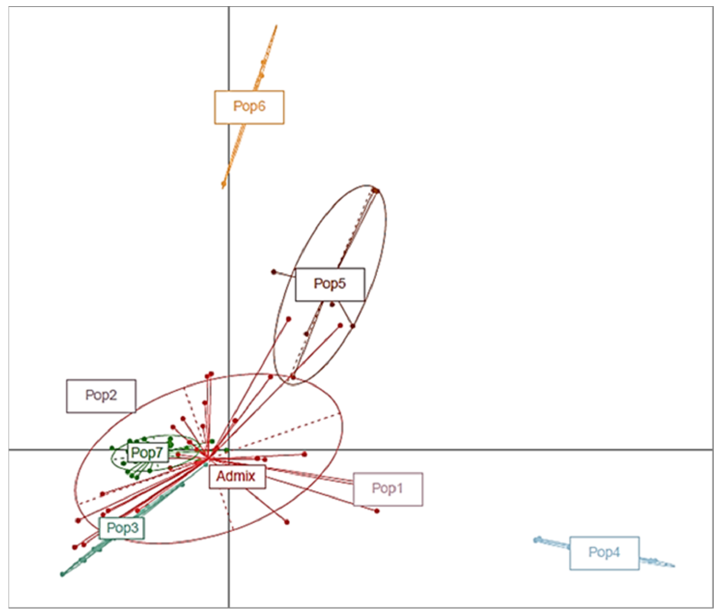
Figure 3. Principal coordinate analysis (PCoA). The analysis depicts the overall genetic diversity of the germplasm for 96 olive accessions using 54,075 SNP markers.